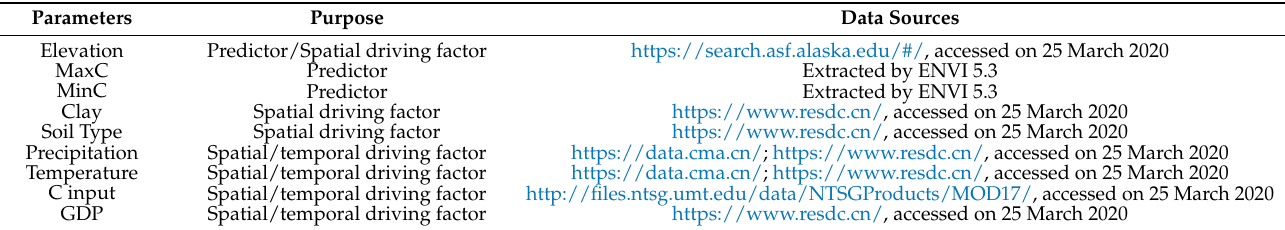
Table 3. The auxiliary variables used in the study